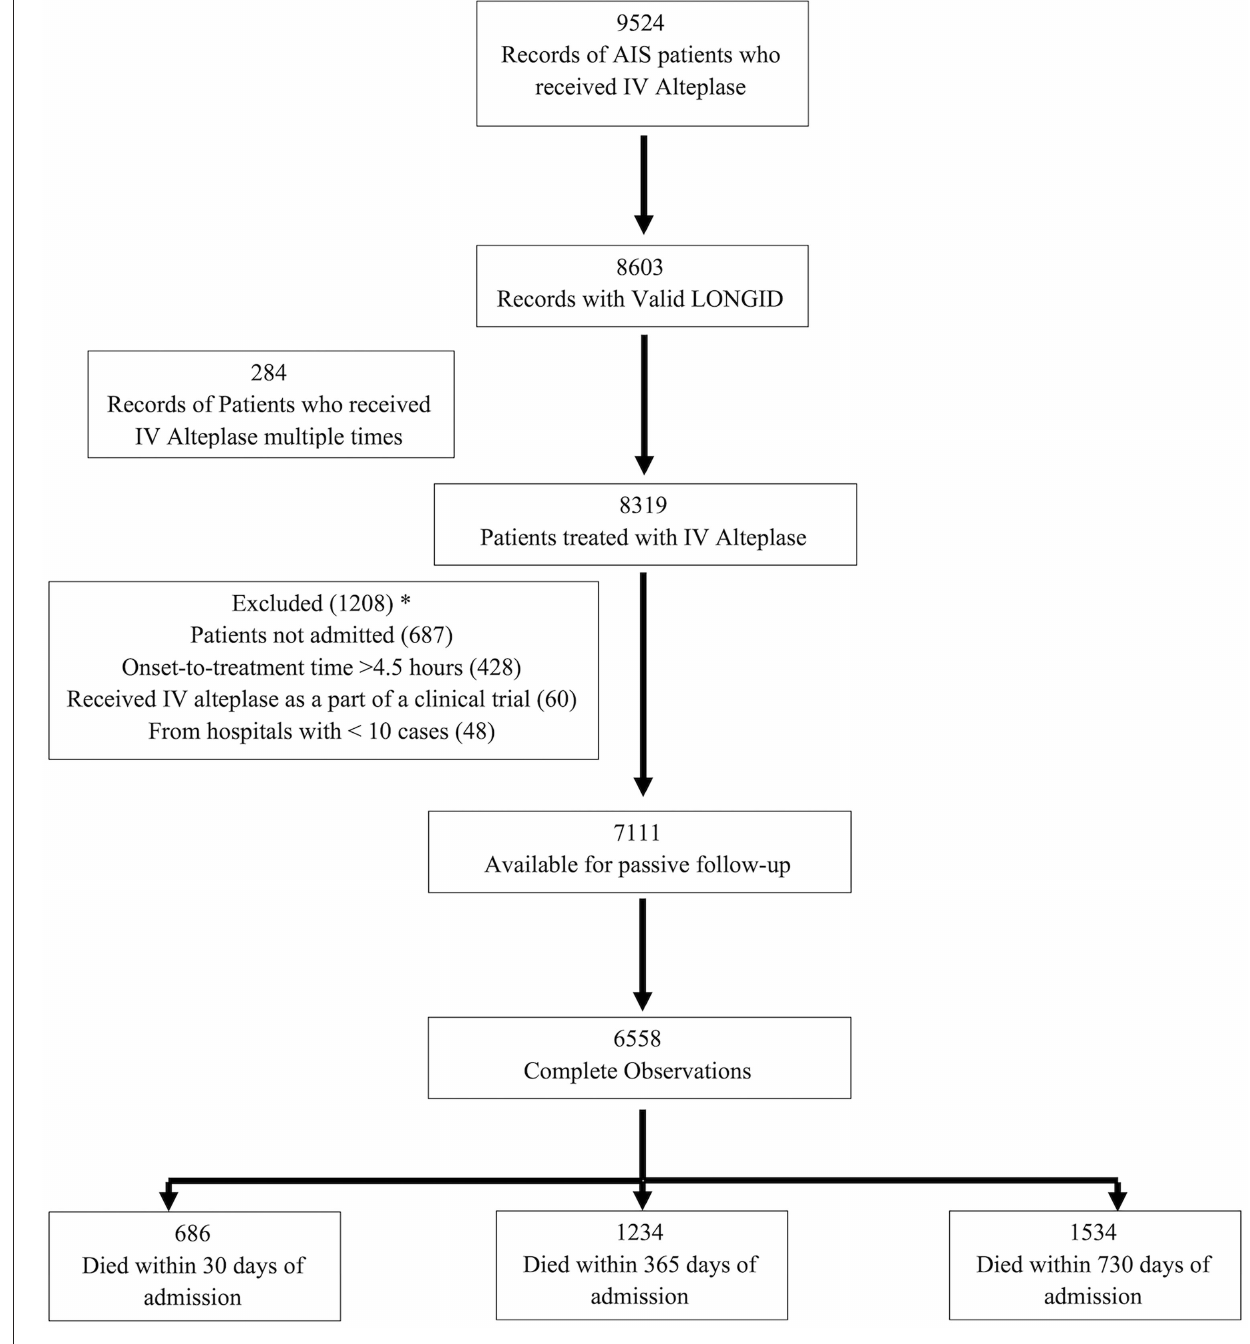
FIGURE 1 | Flow chart for the number of subjects included in the analyzes. *Some patients had > 1 reason for